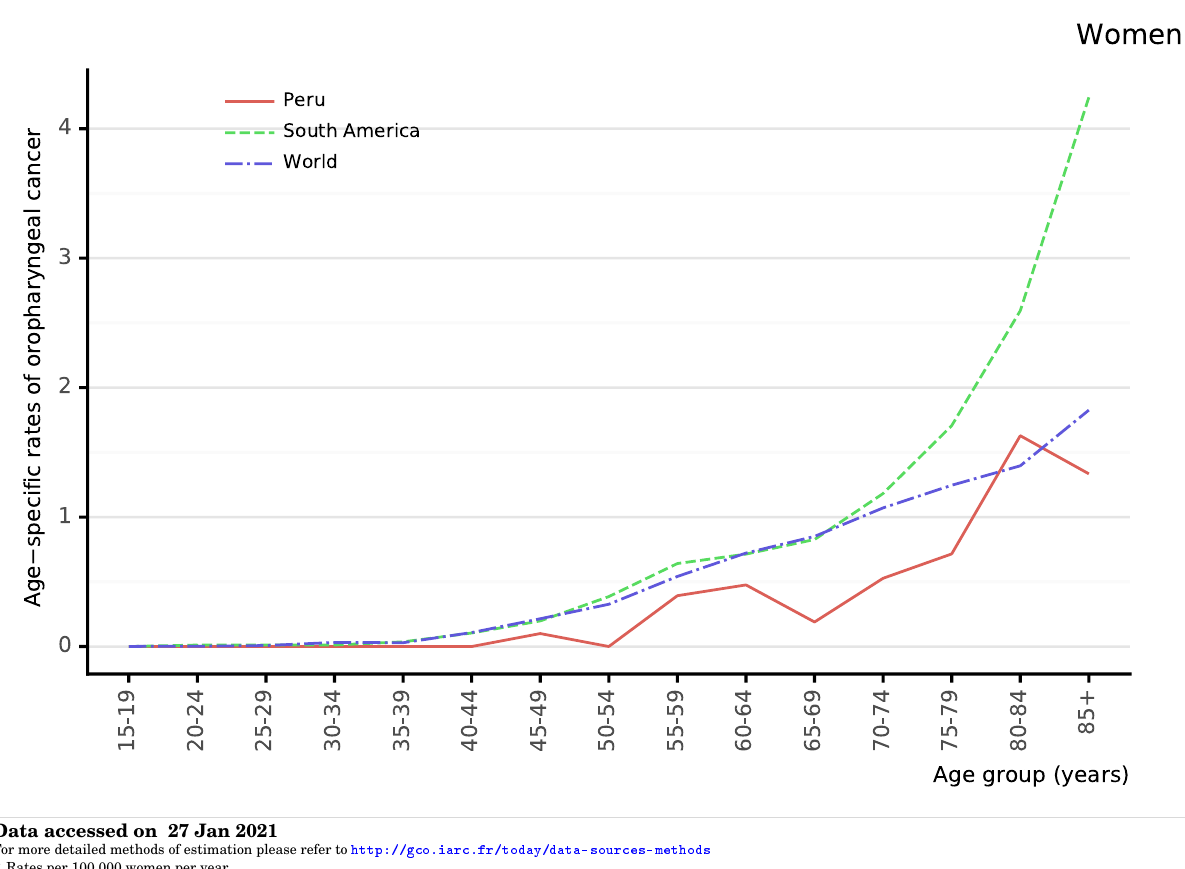
Figure 126: Comparison of age-specific oropharyngeal cancer mortality rates among women by age in Peru, within the region, and the rest of